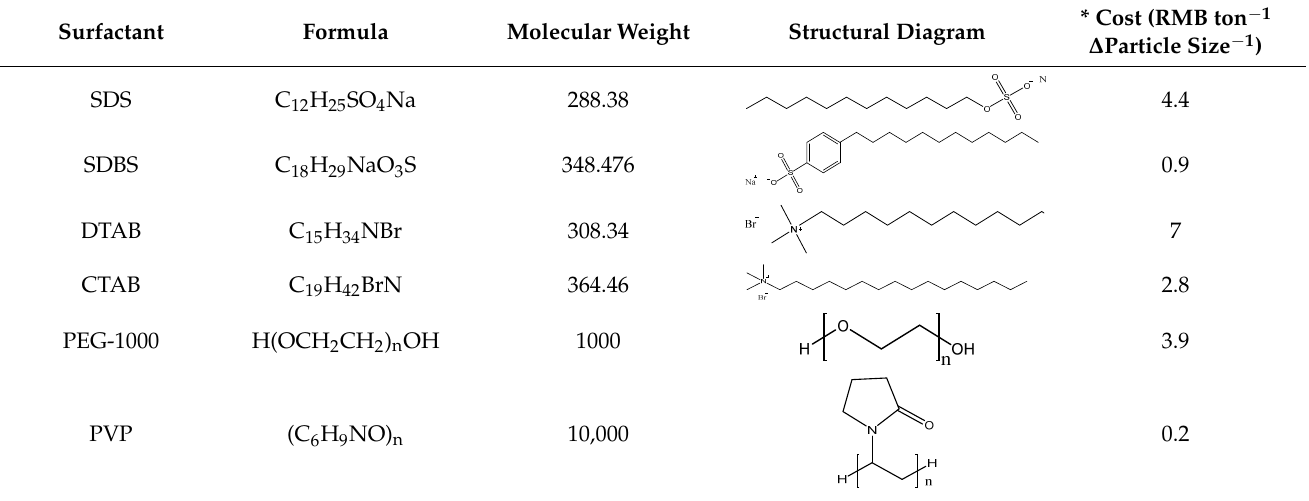
Table 1. Chemical structure and normalized cost of different surfactants.